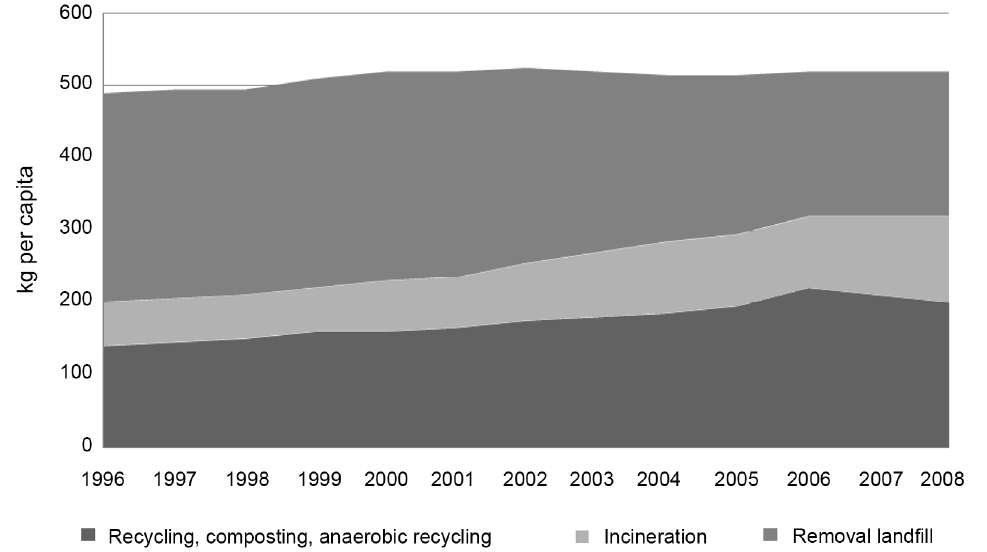
Fig. 2. The tendency of municipal waste utilisation in the European Union (Waste statistics...